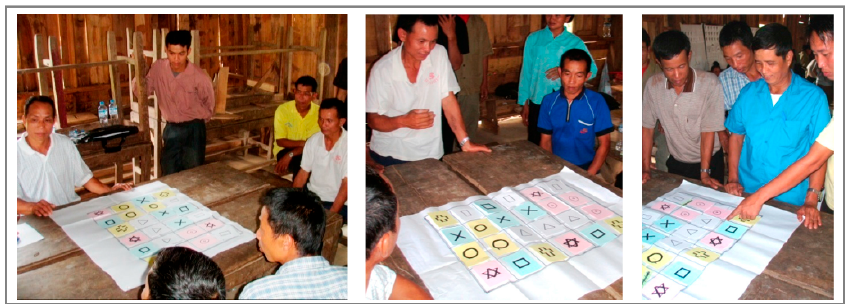
Figure A3. Game board in Natong Village.